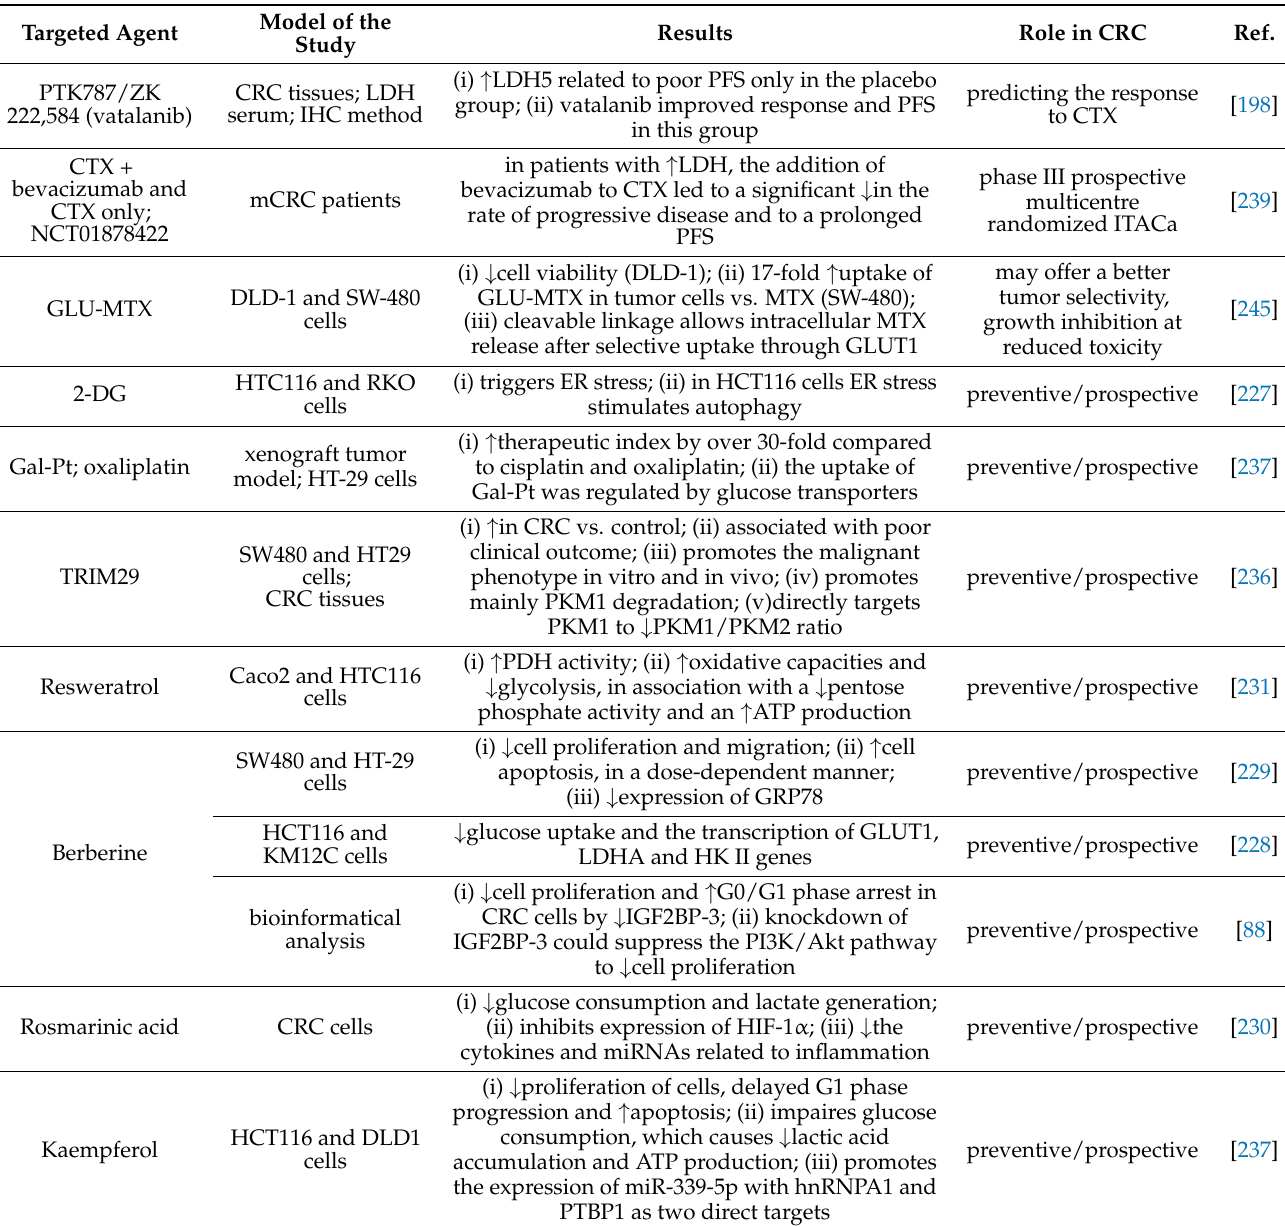
Table 4. Examples of therapeutical options for anti-aerobic glycolysis (Warburg effect) in colorectal cancer. Model of the Targeted Agent Results Role in CRC Study